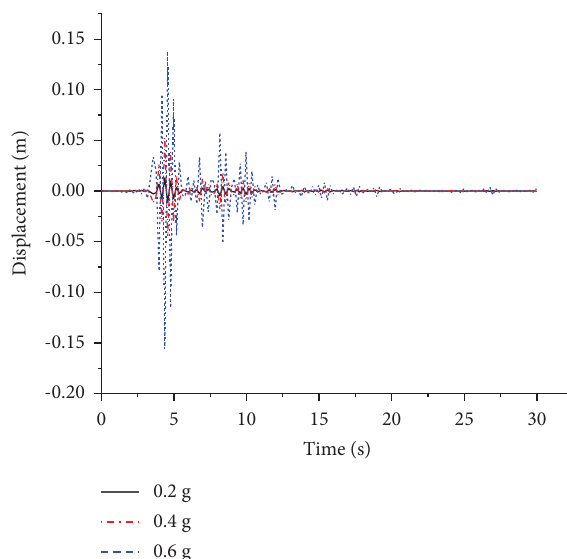
Figure 18: Displacement time-history curves of Northridge wave under diferent modulated amplitudes.